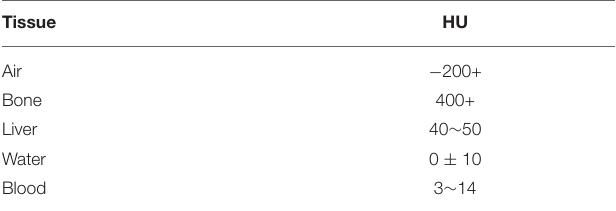
TABLE 1 | Typical tissues radiodensities of human body.